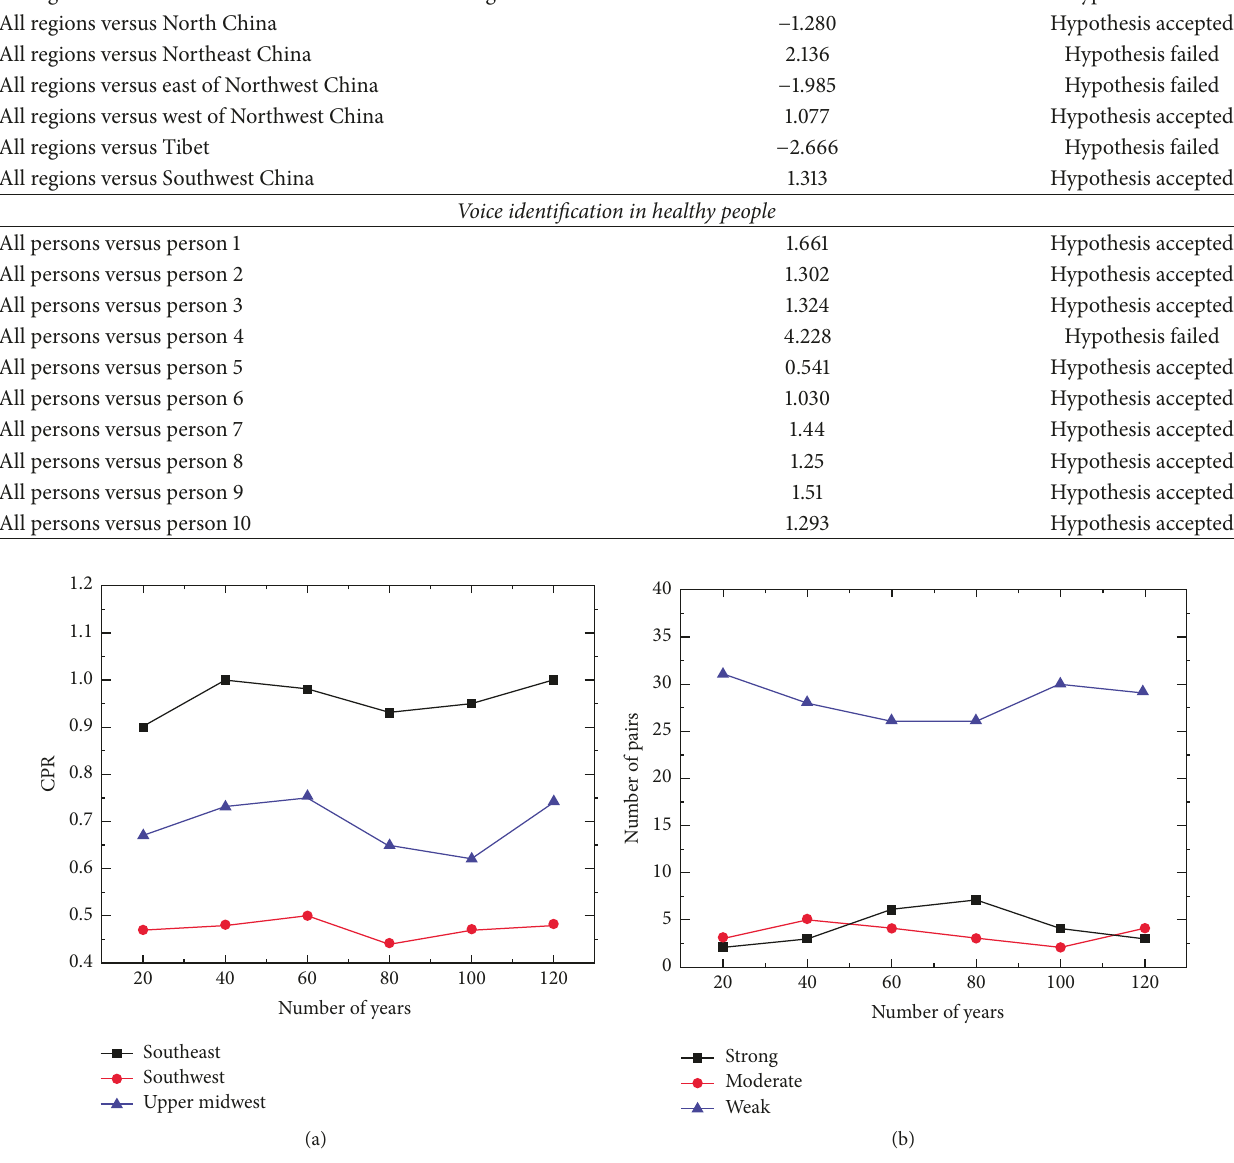
Figure 16: Scalability of the CPR based approach in terms of (a) CPR value. (b) Number of